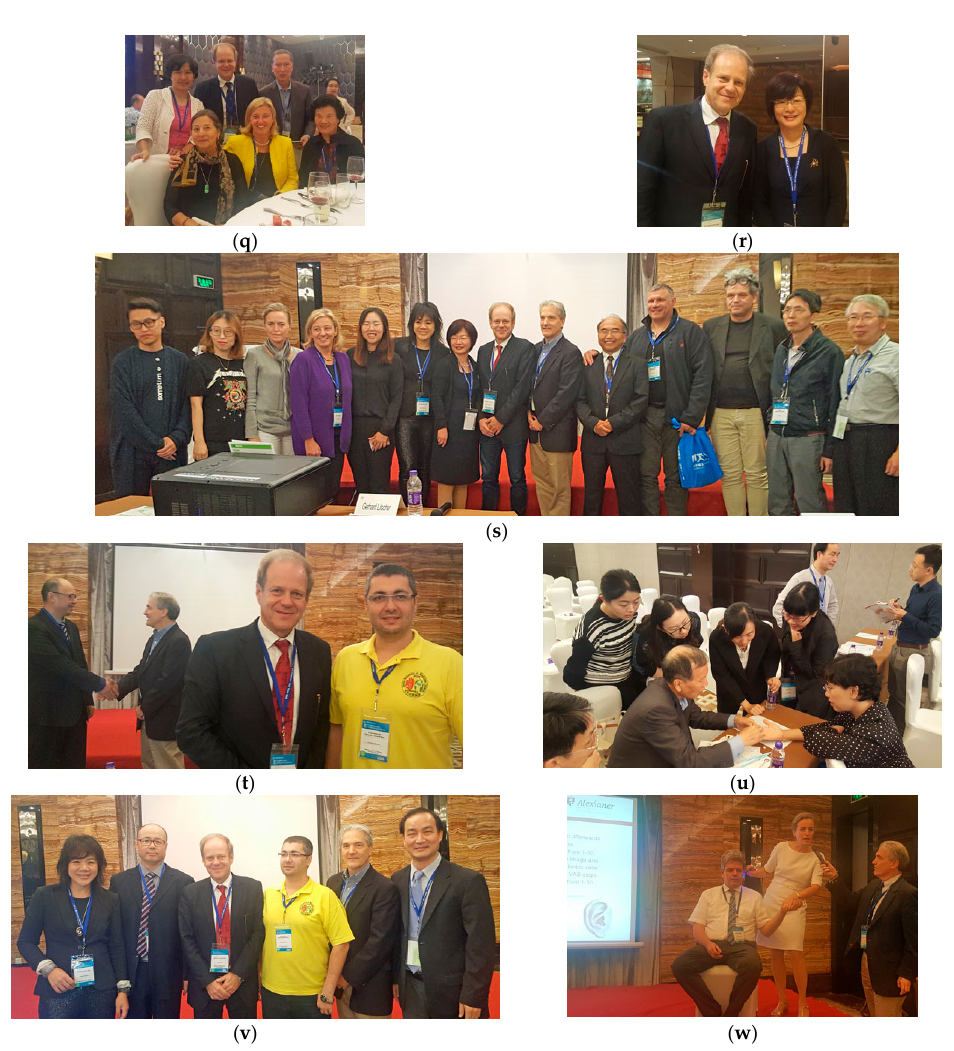
Figure 22. Fourth Annual World Congress (BIT) of High-Tech Acupuncture and Integrative Medicine: